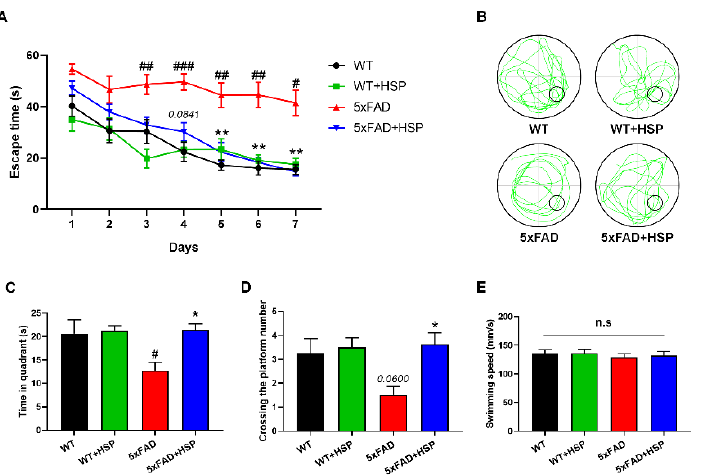
Figure 5. The effects of hesperidin on spatial memory functions in 5xFAD mice. ( A ) Escape time (s) of mice over 7 days. ( B ) Representative swimming paths on day 8. ( C – E ) On day 8 of the probe trial, time in quadrant ( C ), crossing the platform number ( D ), and swimming speed ( E ) were recorded. Statistical analysis included one- or two-way analysis of variance and Tukey’s post hoc test. # p < 0.05, ## p < 0.01, and ### p < 0.001 compared with the vehicle-treated WT mice. * p < 0.05 and ** p < 0.01 compared with the vehicle-treated 5xFAD mice. Data are shown as mean ± SEM (WT mice, n = 12; WT+HSP mice, n = 12; 5xFAD mice, n = 12; 5xFAD+HSP mice, n = 13). n.s; not significant.